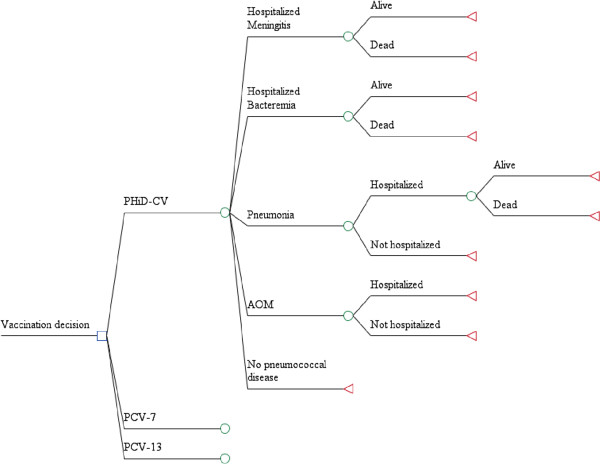
Model structure: decision tree framework. The 10 mutually exclusive health outcomes for pneumococcal-related disease are represented by the 10 branches of the decision analytical model. Although the model is capable of estimating the disutility of long-term sequelae, these were not included in the presented analysis, due to a lack of accurate, region-specific data. AOM = acute otitis media, PCV-7 = 7-valent pneumococcal conjugate vaccine, PCV-13 = 13-valent pneumococcal conjugate vaccine, PHiD-CV = pneumococcal non-typeable Haemophilus influenzae Protein D conjugate vaccine.